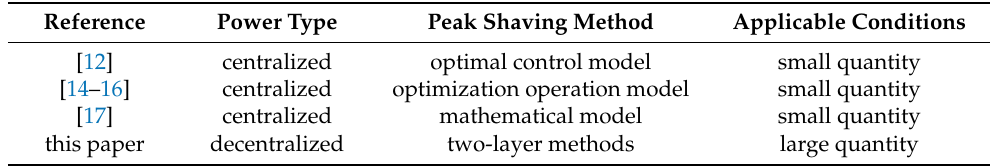
Table 1. Comparison of related work with proposed